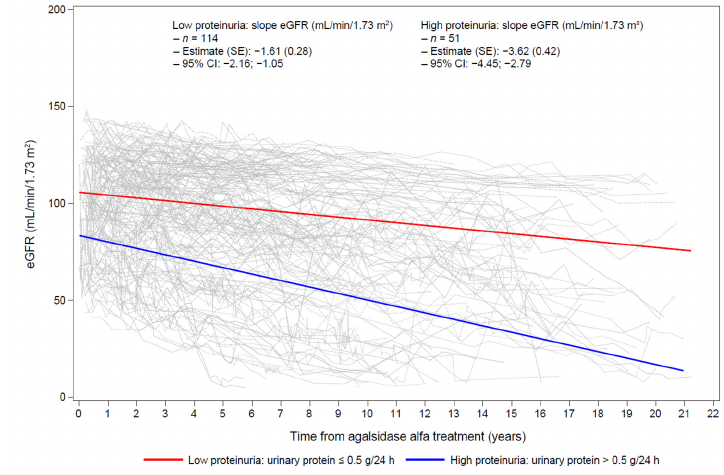
Figure 1. Change in eGFR over time by level of proteinuria at baseline. eGFR was measured using the CKD-EPI equation. CI—confidence interval; CKD-EPI—Chronic Kidney Disease Epidemiology Collaboration; eGFR—estimated glomerular filtration rate; SE, standard error.